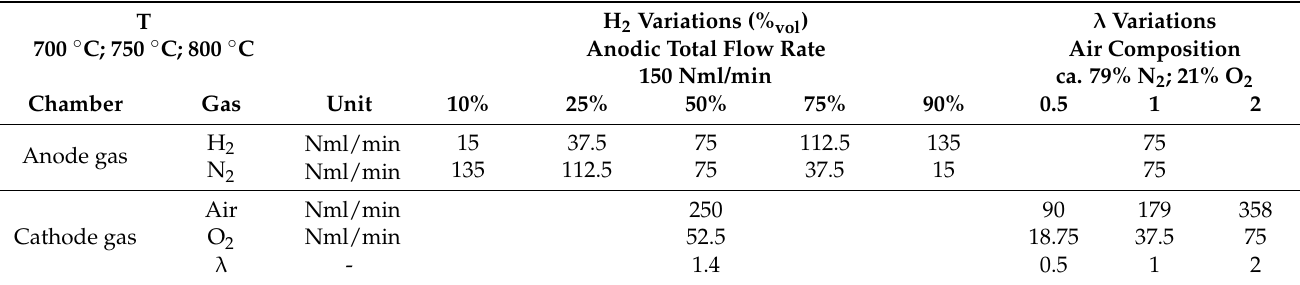
Table 2. Parametric analysis experimental test matrix and assumptions assessing anode H 2 variation (10/25/50/75/90% vol ), cathode λ variation (0.5/1/2) in different operating temperature conditions (700/750/800 ◦